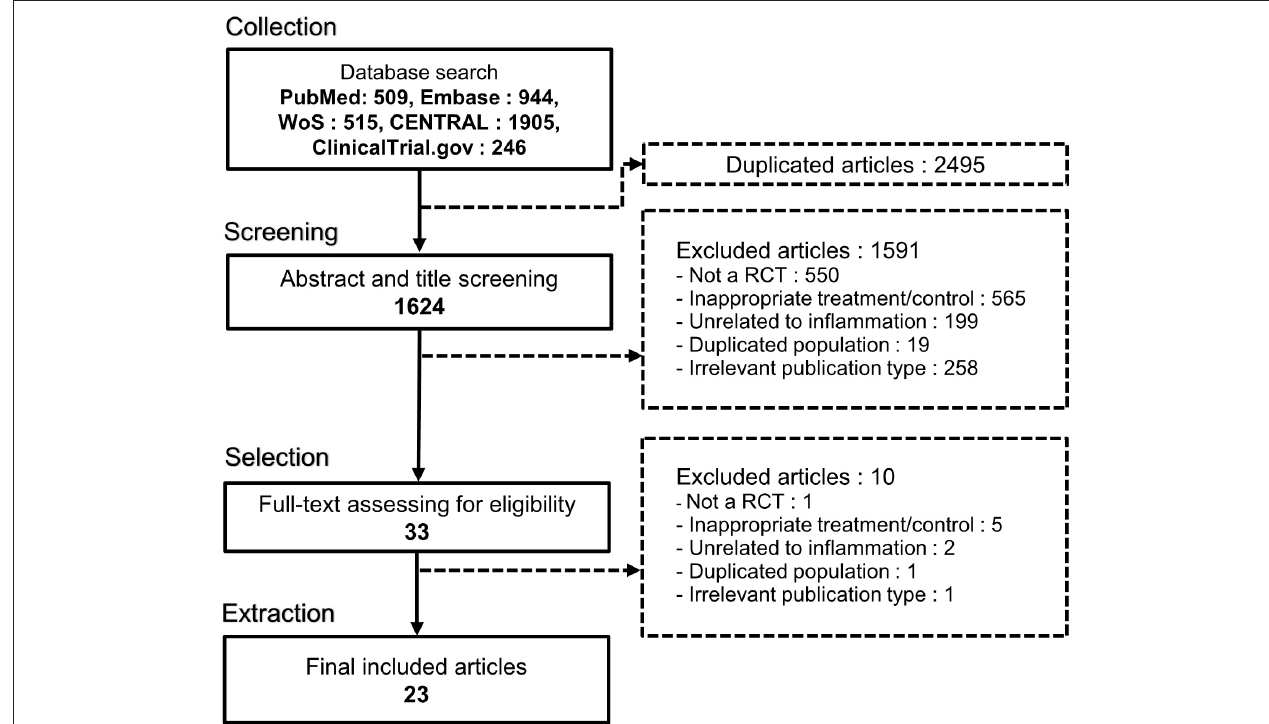
FIGURE 1 | PRISMA flowchart of the study selection